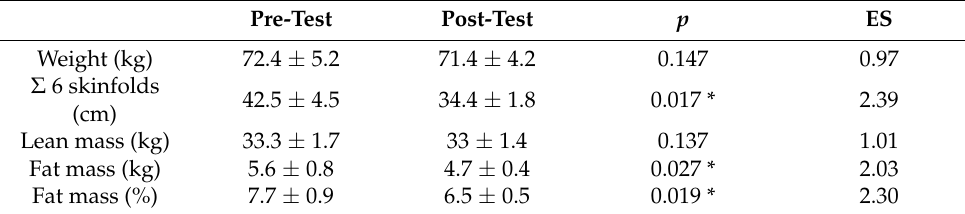
Table 1. Anthropometric characteristics (mean ± SD) of the triathletes pre- and post-training. Pre-Test